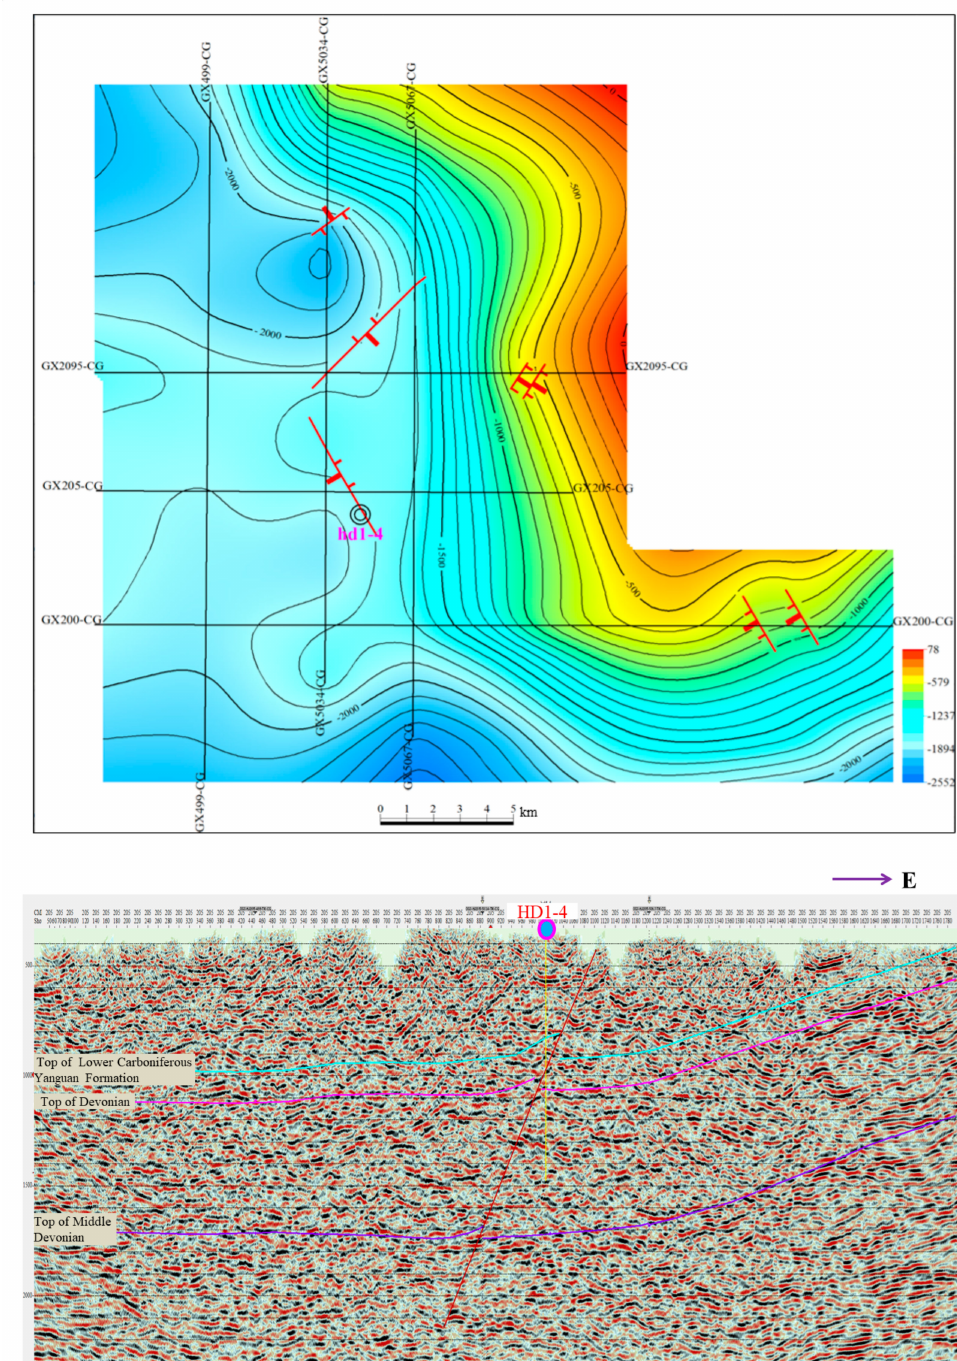
Figure 9. Top figure: structural map of shale top surface of Carboniferous Yanguan formation in Huanjiang syncline (according to the interpretation data of 2D seismic GX205-CG strata; isoline represents depth.) Bottom figure is an E–W 2D seismic, fault and strata interpretation profile near HD1 wells (HD1 wells are located in the